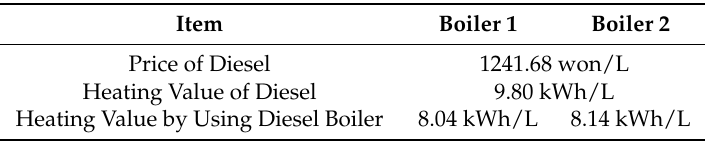
Table 7. Diesel price and diesel heat efficiency.